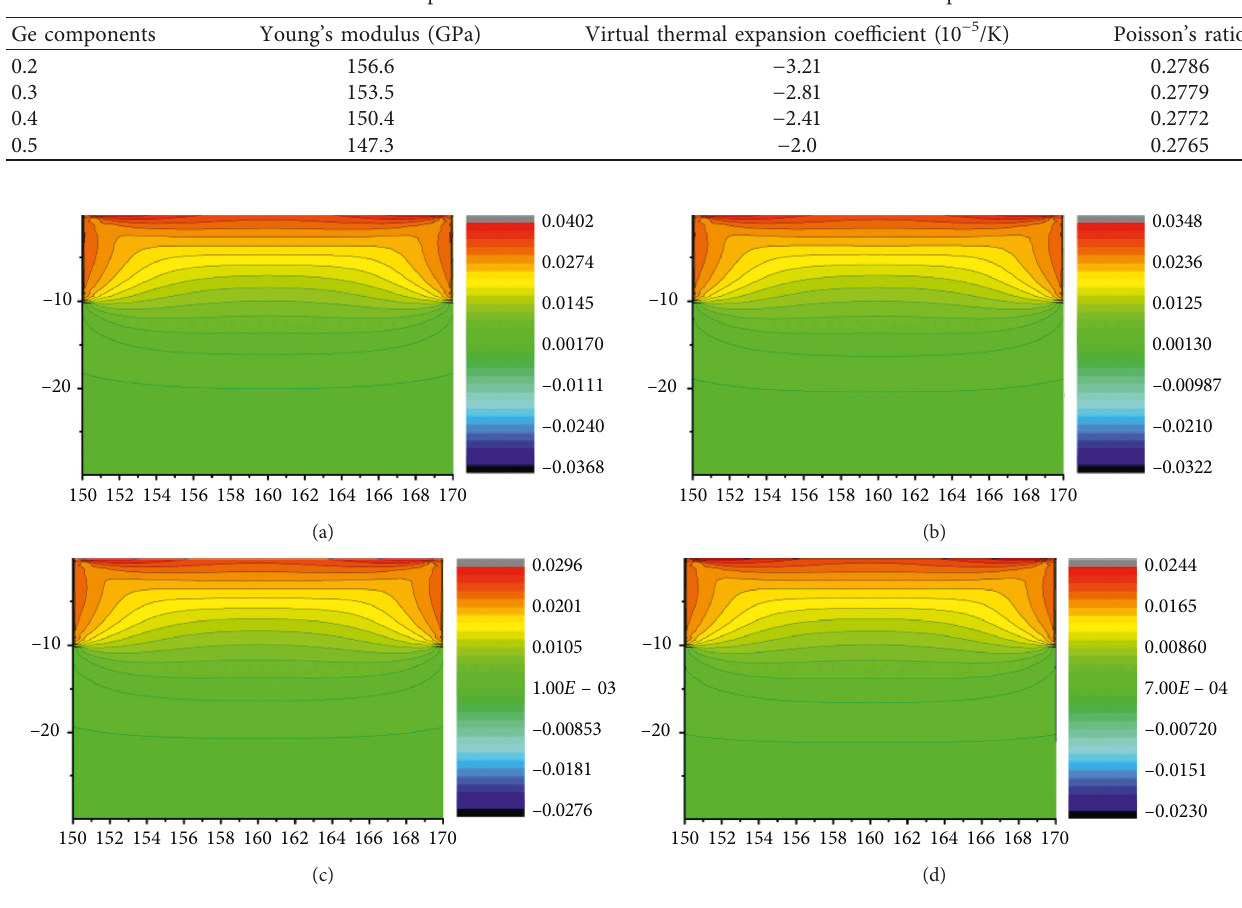
Figure 11: Distribution of ε xx in the mesa region when the Ge component is 0.2, 0.3, 0.4, and